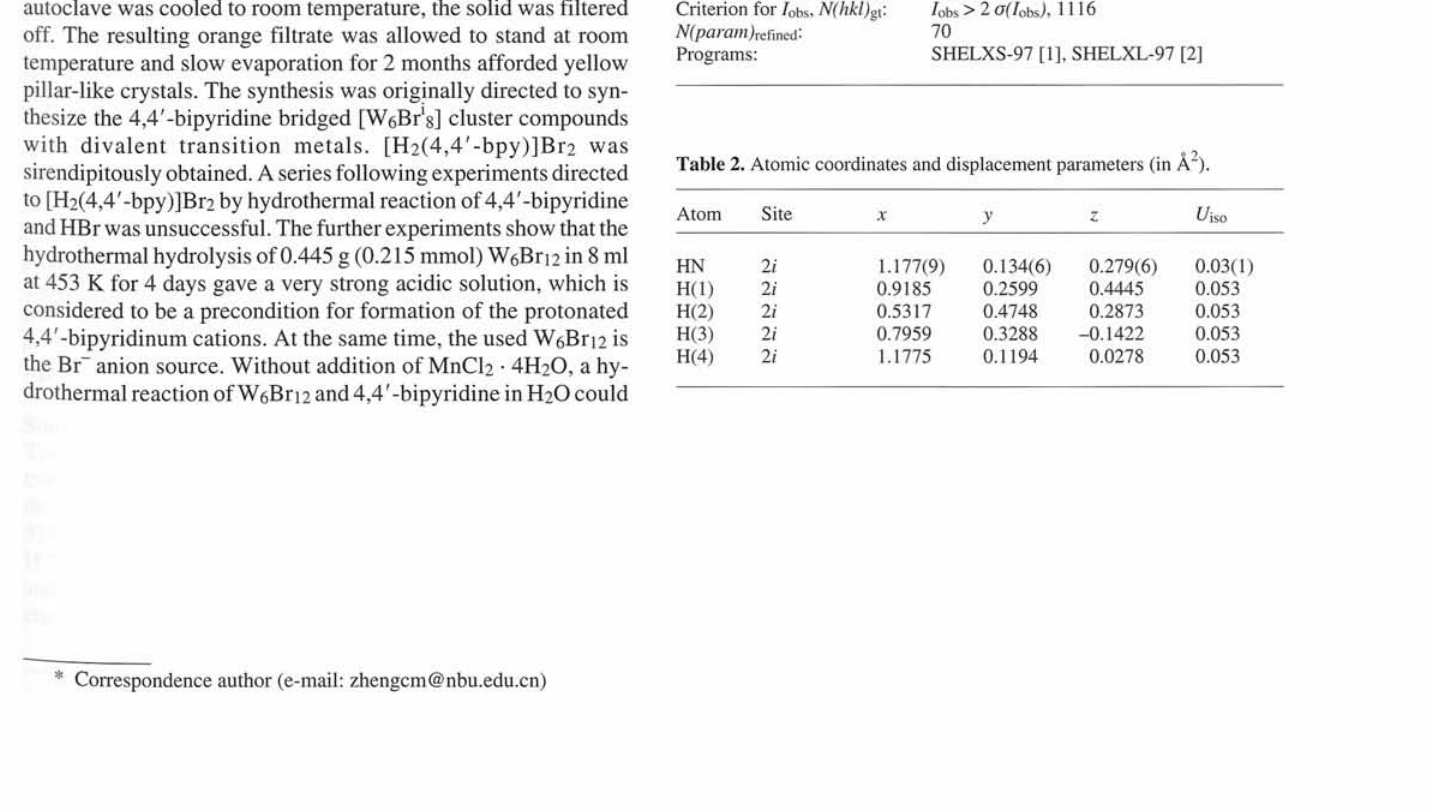
Table 2. Atomic coordinates and displacement parameters (in À 2